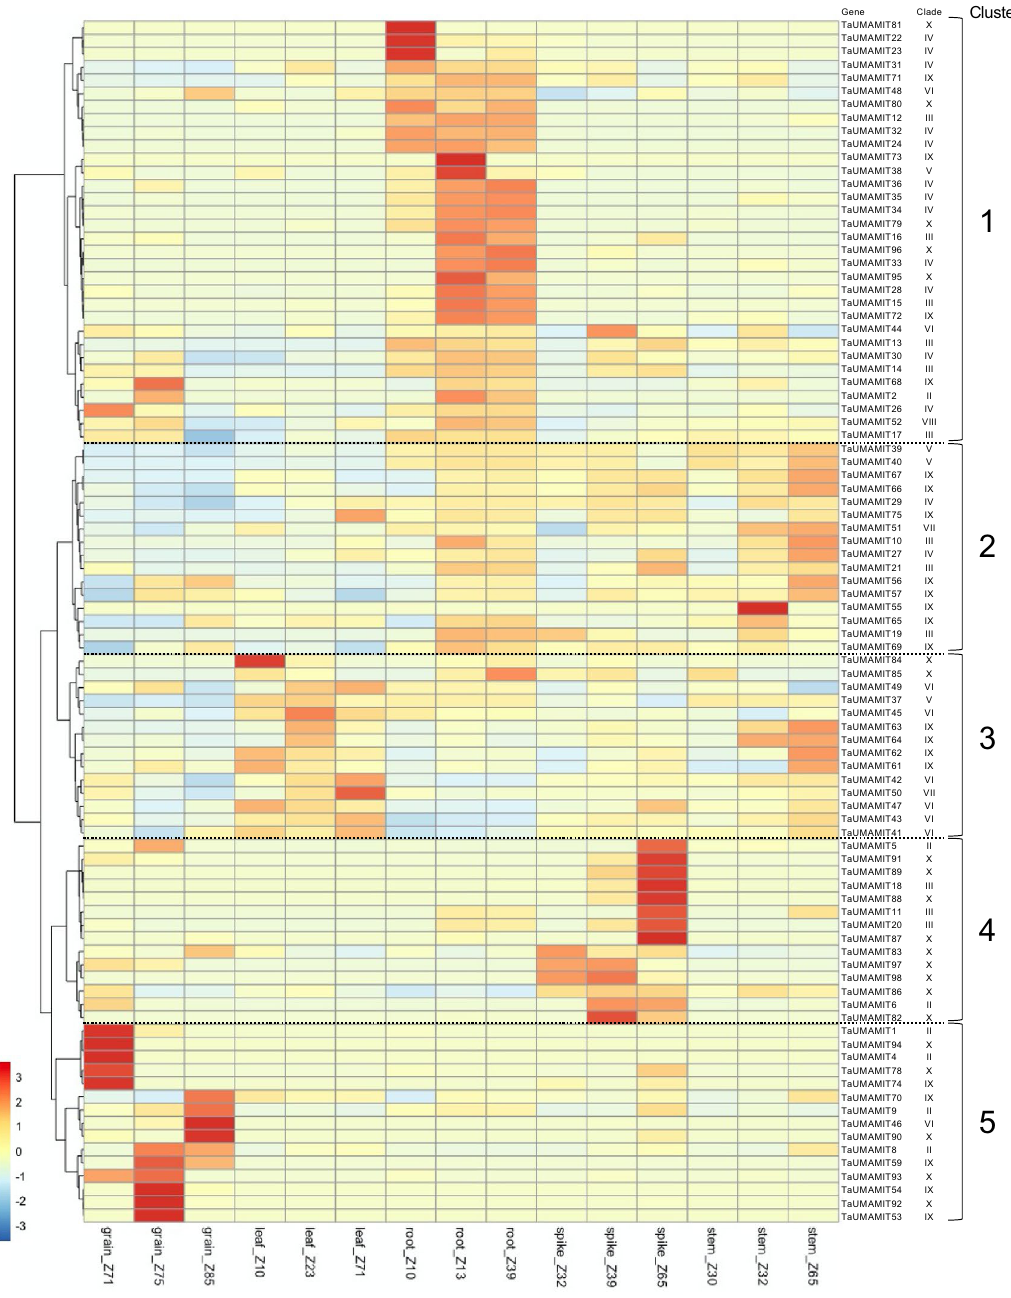
Figure 3. Expression of UMAMIT genes in different organs. The heatmap is scaled by row (each gene). For each gene, expression values were averaged for all representing wheat subgenomes. Growth stages are expressed in Zadoks growth scale (i.e. Z71 represents Zadoks stage 71). UMAMIT genes without expression in any of the cell type has been excluded from the